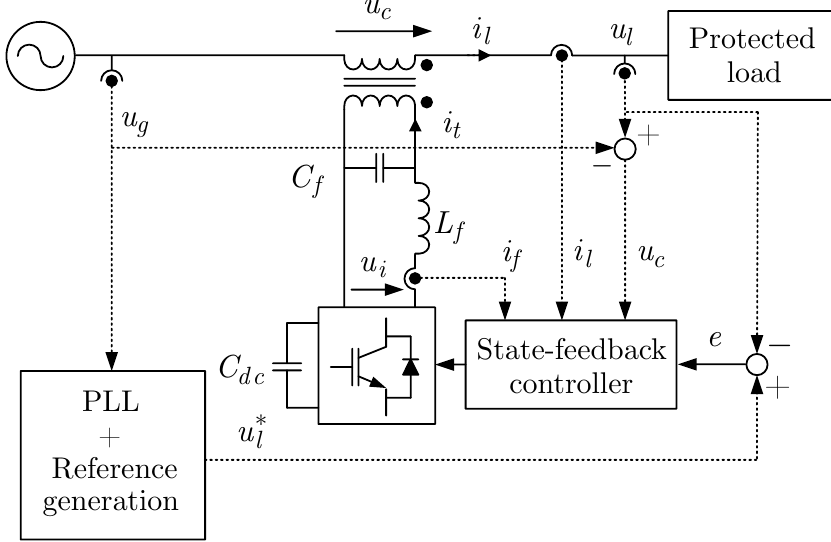
Figure 2. Single-phase schematics of the proposed set-up and the controller of a